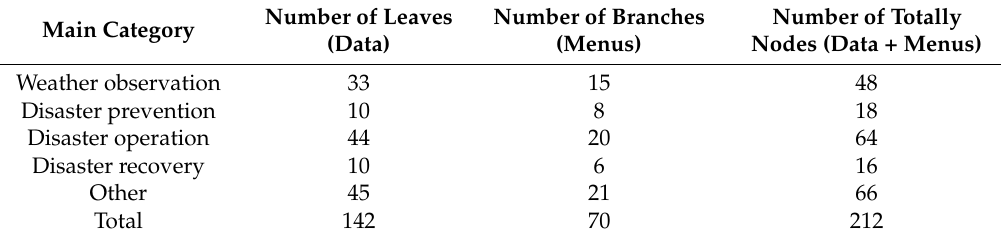
Table 2. The data distribution in the decision tree.